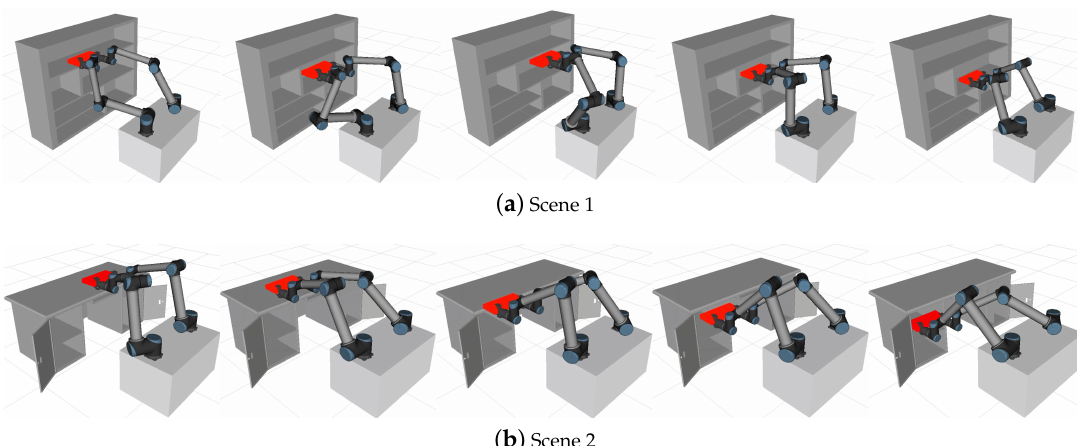
Figure 6. The snapshots of a dual-arm robot performing constrained motion tasks. The object had to be kept level in the process of transferring.